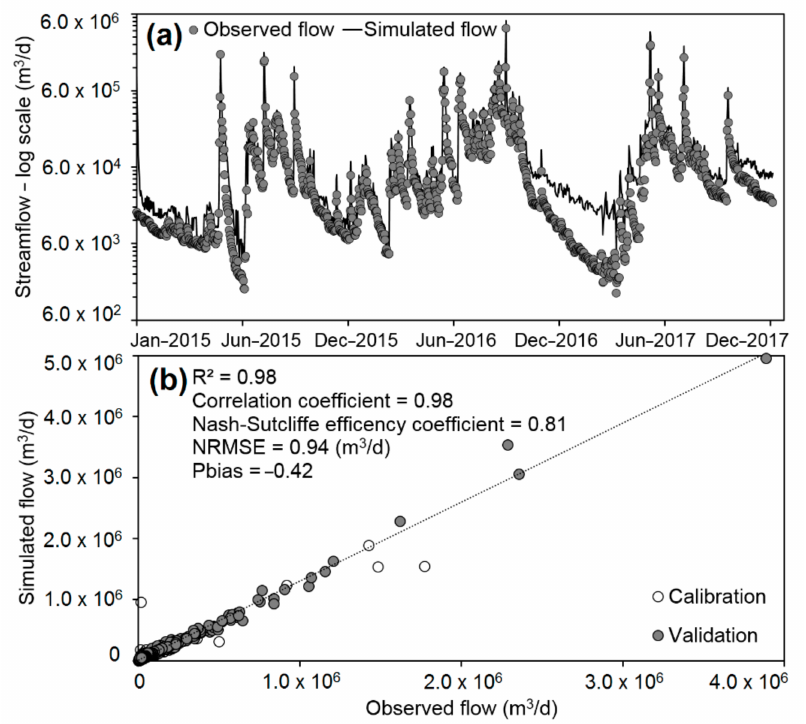
Figure 8. The comparison of the observed and simulated streamflow at Wanda station in the Kaoping River: ( a ) the variations of stream discharge rates in logarithmic scale, and ( b ) the scatterplot of simulated and observed stream discharge rates and the associated performance statistics for the